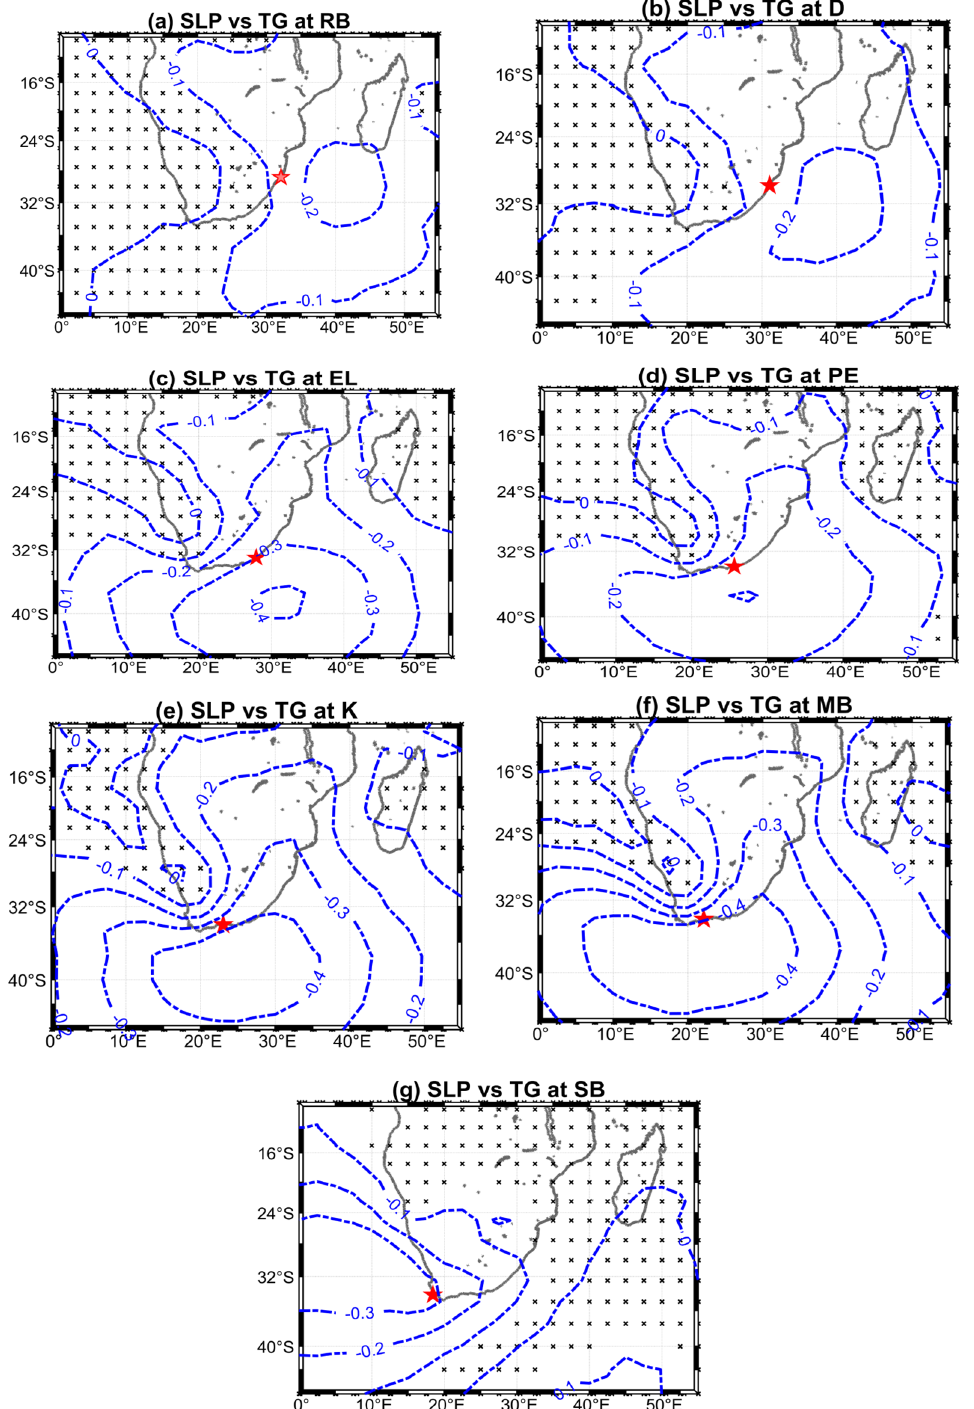
Figure 2. Correlation, on the sub-annual timescale, between regional gridded monthly mean SLP and monthly mean SL records at ( a ) Richards Bay, ( b ) Durban, ( c ) East London, ( d ) Port Elizabeth, ( e ) Knysna, ( f ) Mossel Bay and ( g ) Simons Bay, respectively. Red stars indicate the tide gauge location. Black crosses indicate areas statistically non-significant at 95% confidence level, estimated using a two-sided t -test.